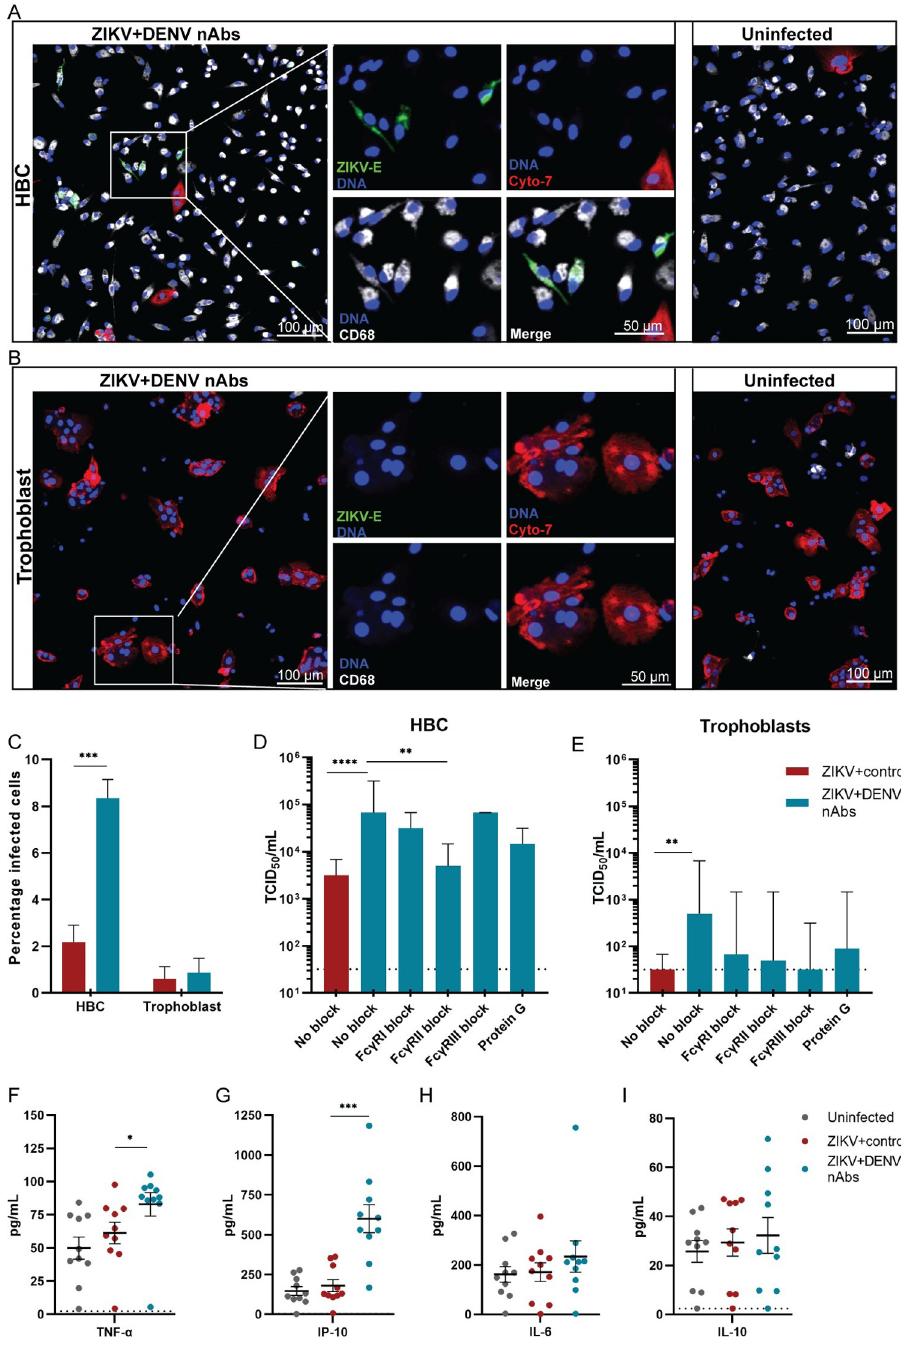
Fig 5. Primary Hofbauer cells are permissive for ZIKV infection and ADE of ZIKV infection. Hofbauer cells (HBCs) and trophoblasts were isolated from term human placentas and infected with ZIKV+flavivirus naive serum (ZIKV+control) or ZIKV+DENV nAbs at an MOI of 0.5 in presence or absence of Fc γ R blocking antibodies and protein G, for 48 hours. A: Confocal laser scanning microscopy image of ZIKV+DENV nAbs infected HBCs and uninfected HBCs. B: Confocal laser scanning microscopy image of ZIKV+DENV nAbs infected trophoblasts and uninfected trophoblasts. HBCs were visualized by fluorescent staining for CD68, trophoblasts for cytokeratin-7 (Cyto- 7), ZIKV by staining for ZIKV envelope protein (ZIKV-E) and nuclei with Hoechst 33342 staining (DNA). C: Percentage of infection of HBCs and trophoblasts was determined with confocal laser scanning microscopy. Bars represent mean+SEM. Significance was determined with a Student’s T-test. D&E: ZIKV titers were determined in supernatants of HBCs and trophoblasts. Bars represent median+95%CI. Significance was determined using